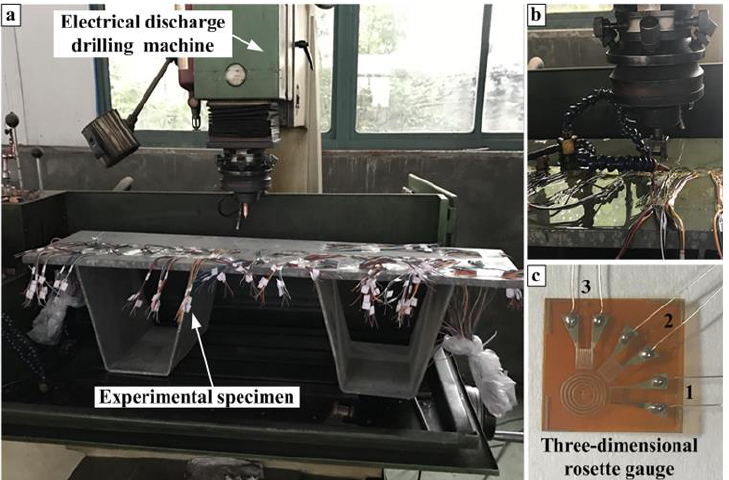
Figure 2. Experimental device: ( a ) test drilling equipment; ( b ) electric pole; ( c ) strain gauge.